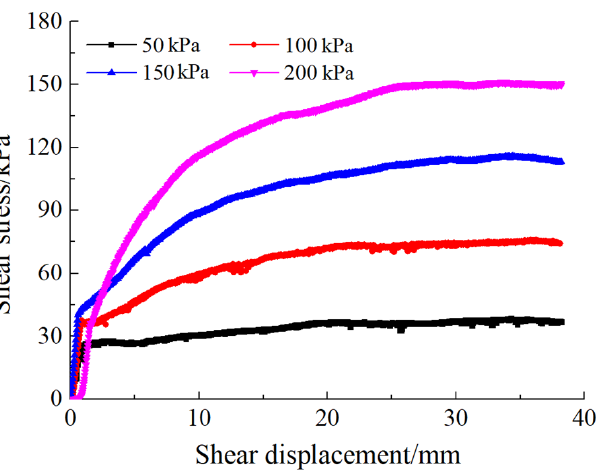
Figure 12. The relation curve of the interface shear stress and shear displacement of sand itself.